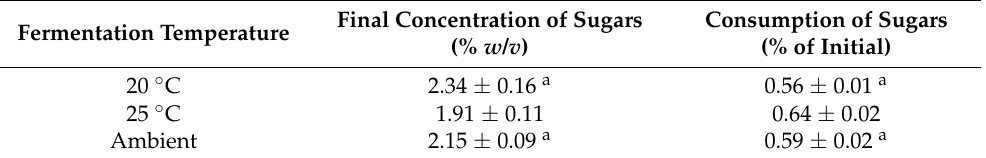
Figure 2. Consumption of sugars ( a ), pH drop ( b ), and distribution of final fermentation products ( c ) during the 24h fermentation of milk with kefir grains at different temperatures. The same letter above columns of each metabolite indicates that values do not differ significantly from each other (Mann – Whitney U-test). Table 2. Final concentration of sugars and total estimated sugars consumption during the 24 h fermentation of milk with kefir grains at different temperatures. Values in each column that share the same letter do not differ significantly from each other (Mann – Whitney U-test).